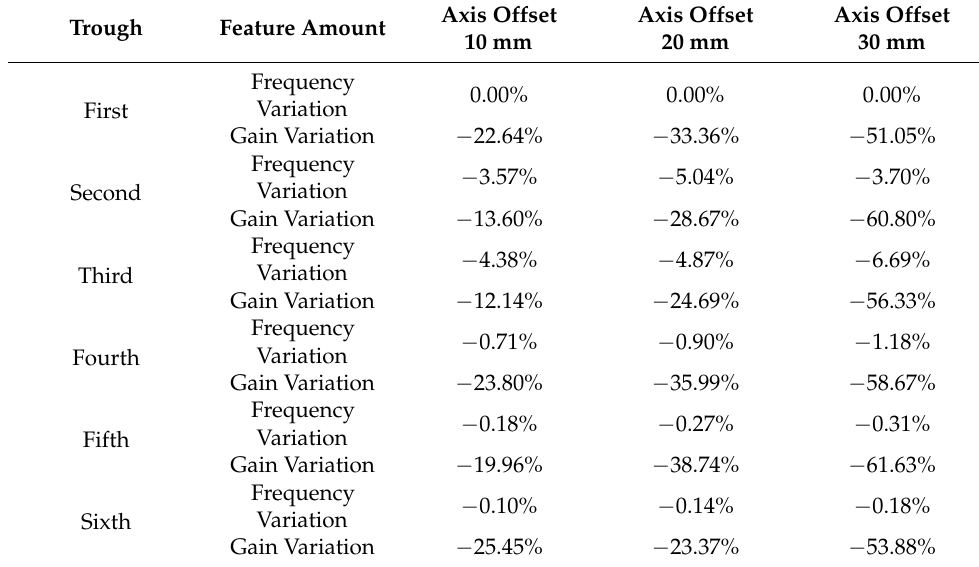
Table 14. Variation in valley frequency and amplitude gain.